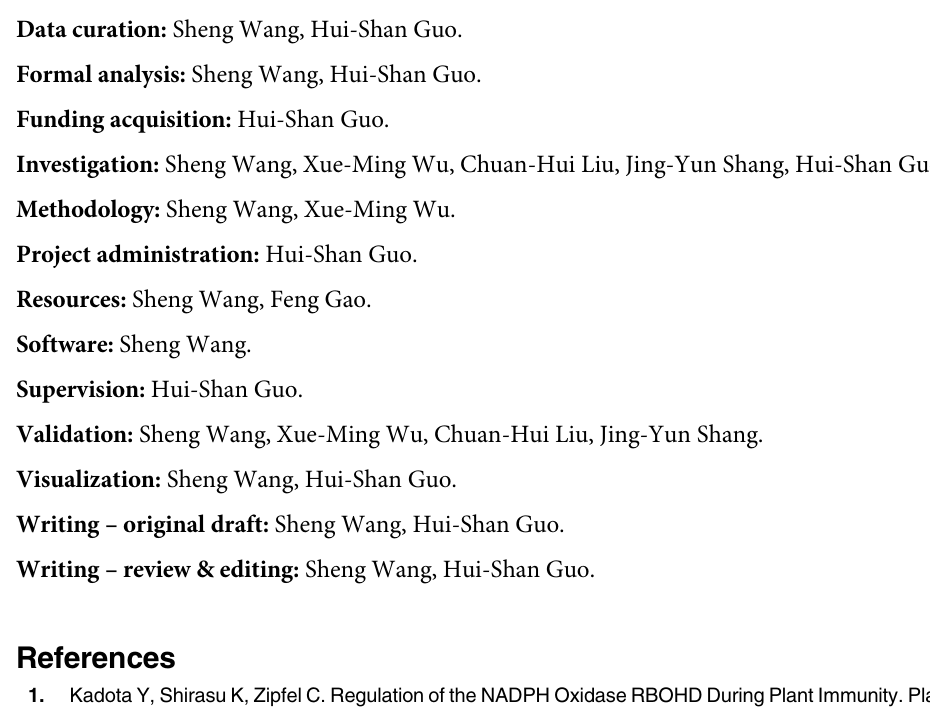
of RNA polymerase II was reduced in the Vd Δ dpb4 mutant strain compared with the wild- type V592 strain. ChIP assays were conducted with an anti-Pol II antibody. Tubulin was used as a control. E. ChIP-qPCR analysis showing little difference in the recruitment of pol II to the tested DNA repair genes in the Vd Δ isw2 mutant strain compared with the wild-type V592 strain. Tubulin was used as a control. (For B-E, gene name and description were in S3 Fig. For D-E, a scheme at right shows where the oligonucleotides used in each gene. S1 Table. Primer list in this study. S2 Table. Full list protein identified by mass spectrometry